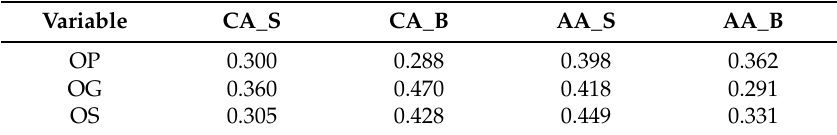
Table 11. Standardized total effects.